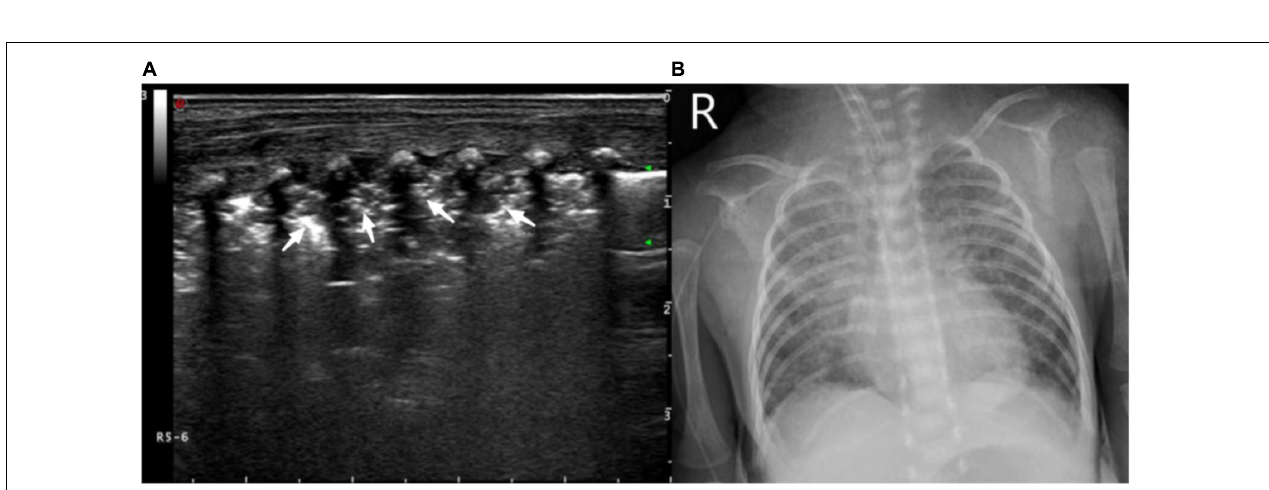
FIGURE 4 | Ultrasonic manifestations of neonatal pulmonary consolidation combined with pleural effusion. Pulmonary ultrasound shows consolidation area with air bronchogram (yellow arrow). A-line disappears, and pleural effusion can be observed. (A) Longitudinal image of the intercostals. (B,C) Transverse image along the intercostals.